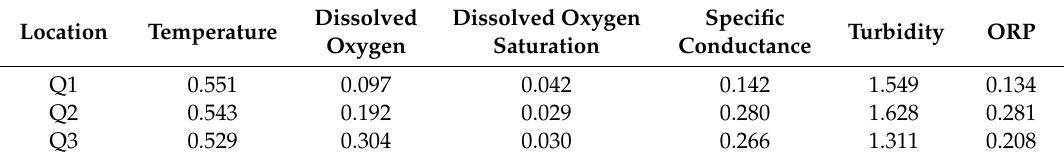
Table 8. Coefficient of variation for water quality measurements from 11 January 2018 to 22 March 2018.